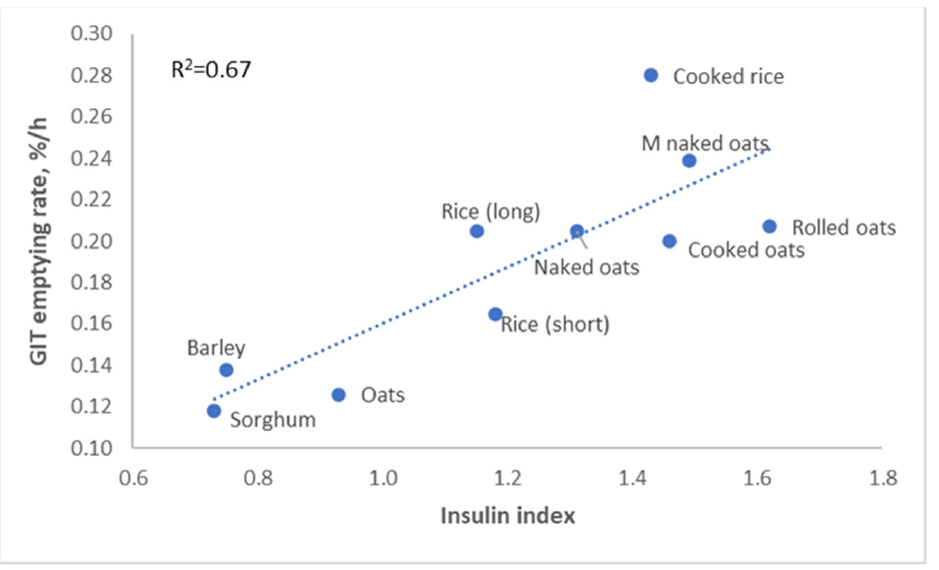
Figure 7. Relation between insulin index and gastro-intestinal tract (GIT) passage rate of cereal grains [19].